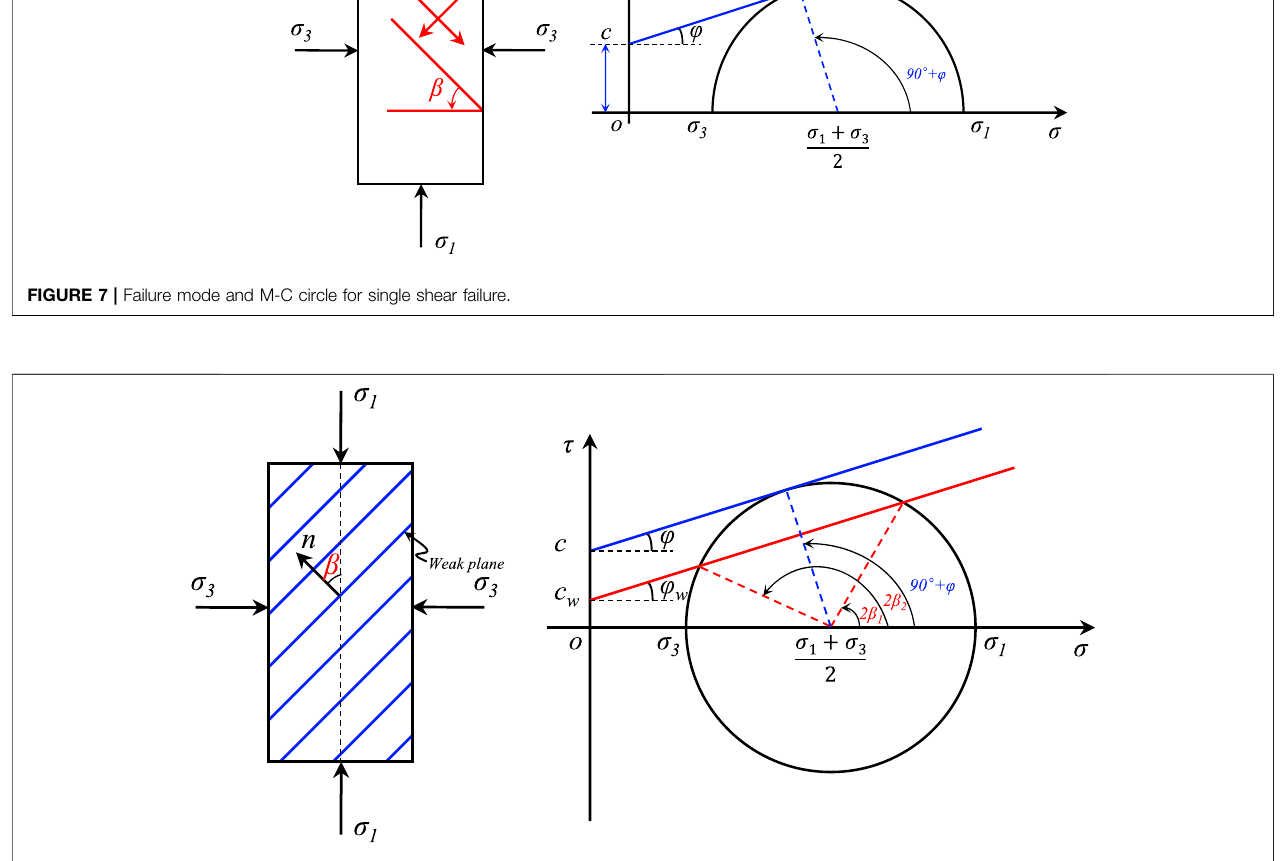
FIGURE 8 | Failure mode under the single weak plane